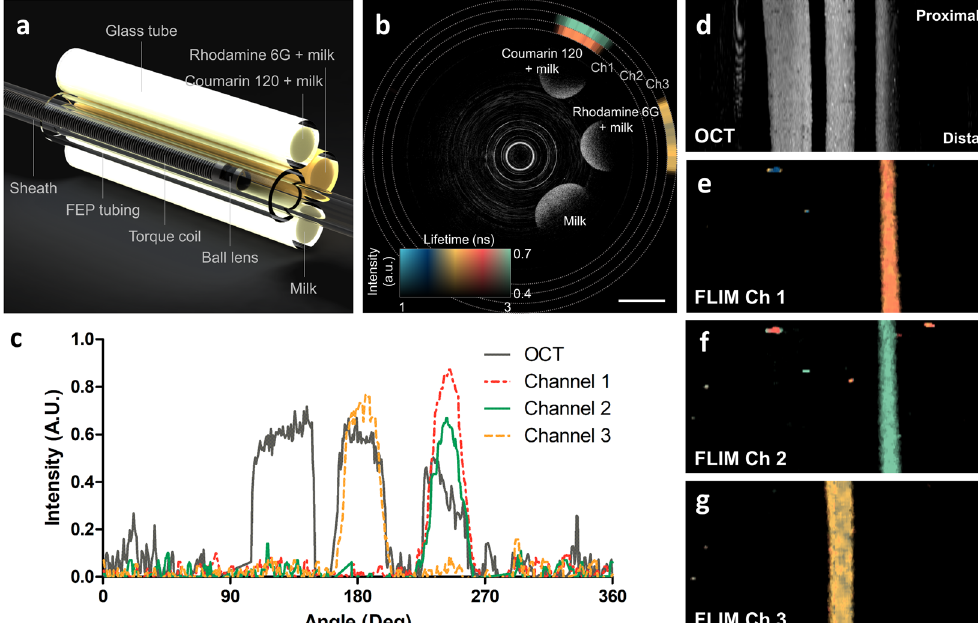
Figure 3. Phantom experiment validating the co-registration between OCT and FLIm. ( a ) Schematic diagram of the phantom consisting of glass tubes filled with milk and standard fluorophores. ( b ) Representative cross- sectional image of phantom. Grayscale and pseudo color represent OCT image and fluorescence lifetime, respectively. ( c ) Intensity graph of OCT and fluorescence along the rotational angle. ( d ) OCT enface map of maximum projection. The two-dimensional fluorescence lifetime maps obtained from channel ( e ) 1, ( f ) 2, and ( g ) 3. Scale bar: 1